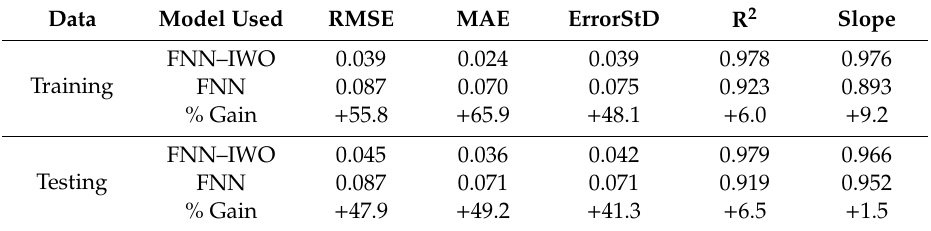
Table 7. Comparison of performance indicators between FNN–IWO and individual